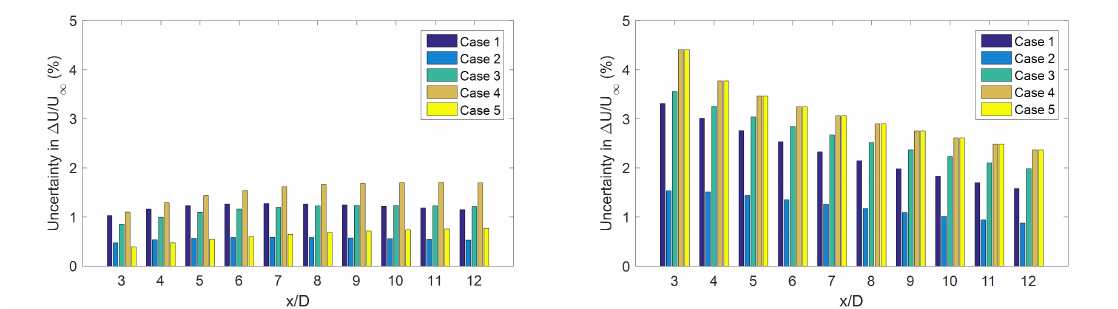
Figure 10. Uncertainty in the normalized velocity defect due to 10% change in the model coefficients in the top-hat ( left ) and in the Gaussian ( right ) wake